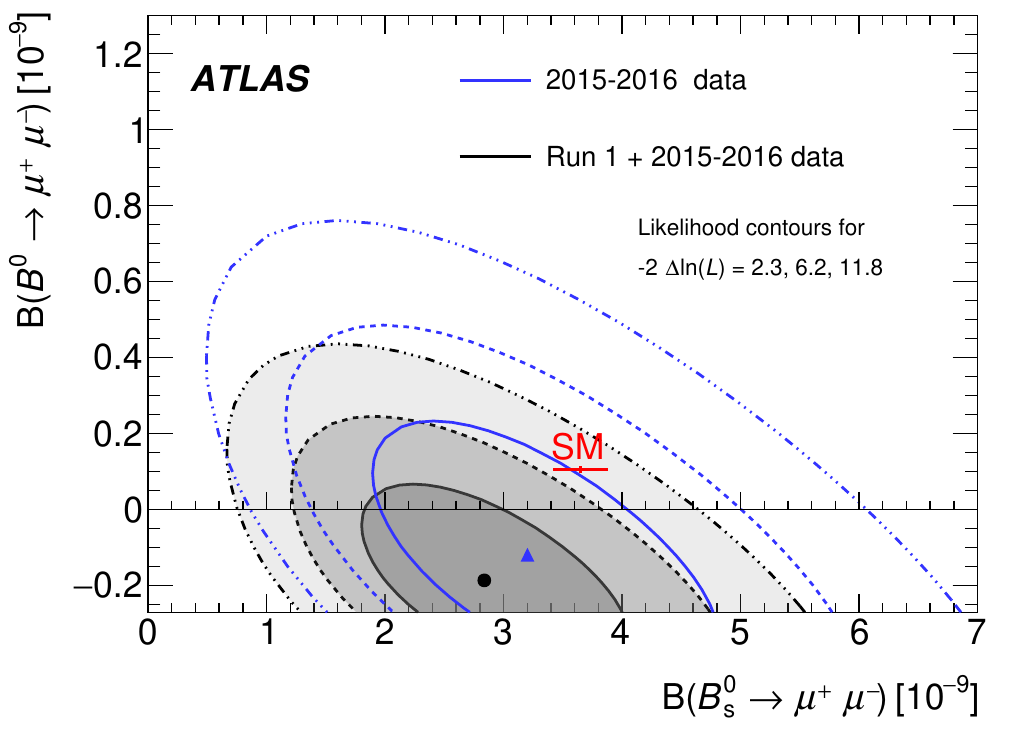
Figure 10. Likelihood contours for the combination of the Run 1 and 2015{2016 Run 2 results (shaded areas). The contours are obtained from the combined likelihoods of the two analyses, for values of (cid:0) 2(cid:1) ln ( L ) equal to 2.3, 6.2 and 11.8. The empty contours represent the result from 2015{2016 Run 2 data alone. The SM prediction with uncertainties is